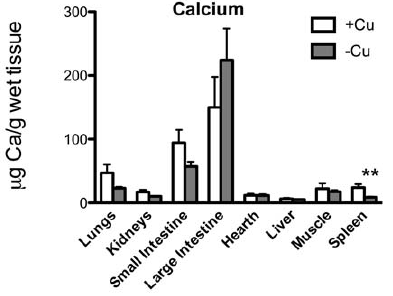
Figure 5. Ca content. Ca ( m g/g wet tissue) in the lungs, kidneys, small intestine, large intestine, heart, liver, muscle, and spleen. ** p ,